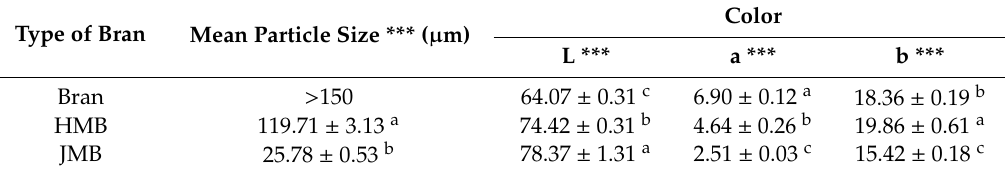
Table 1. The particle size and color characteristics of bran pulverized by hammer mill or jet mill. Type of